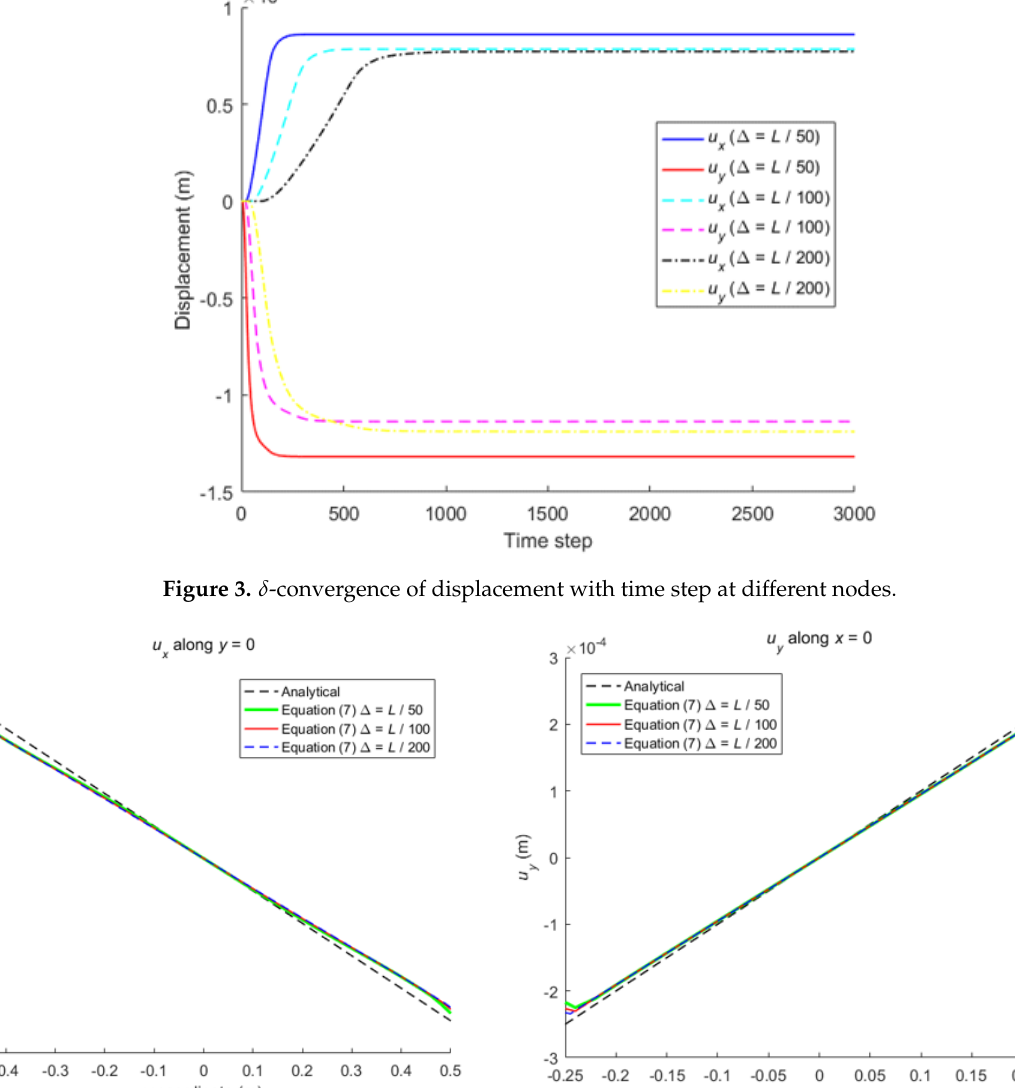
Figure 5. m - convergence of displacement with time step at different nodes.